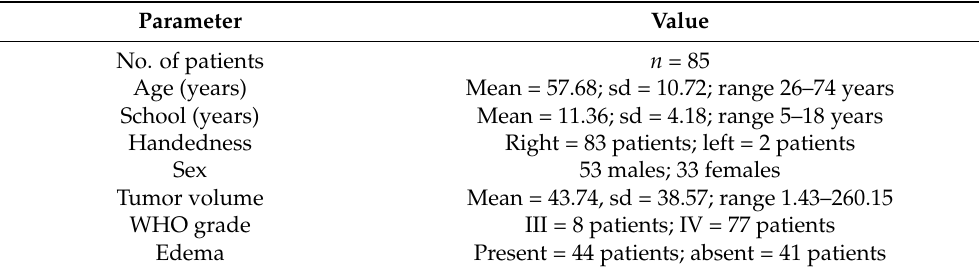
Table 1. Demographic, tumor clinical and histological data of the study